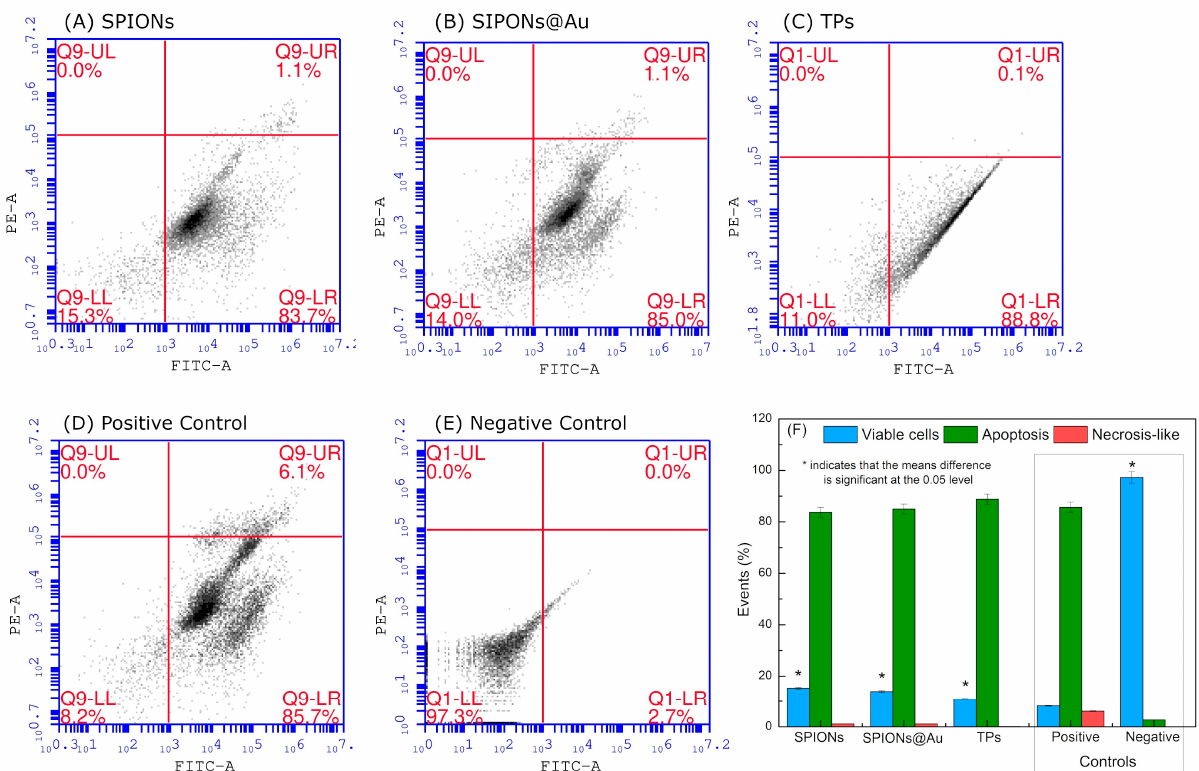
Figure 7. Type of cell death obtained with SPIONs ( A ), SPIONs@Au ( B ), and TPs ( C ) after PTT in the MDA-MB-468 cell line; ( D ) positive control and ( E ) negative control. ( F ) Bar graph with the result of the number of viable cells, necrosis, and apoptosis, obtained by Flow Cytometry for the control and nanoparticle groups.